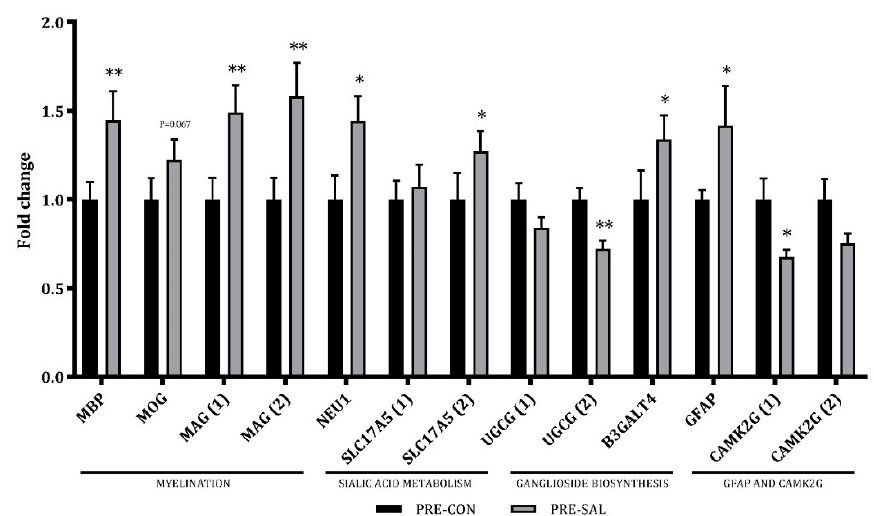
Figure 6. Gene expression in hippocampal tissue. Relative mRNA expression levels of genes related to myelination, sialic acid metabolism, and ganglioside biosynthesis. Numbers in brackets indicate primer number if several primers for same gene were tested. Data are means ± SEM. Statistical difference * p < 0.05; ** p < 0.01.